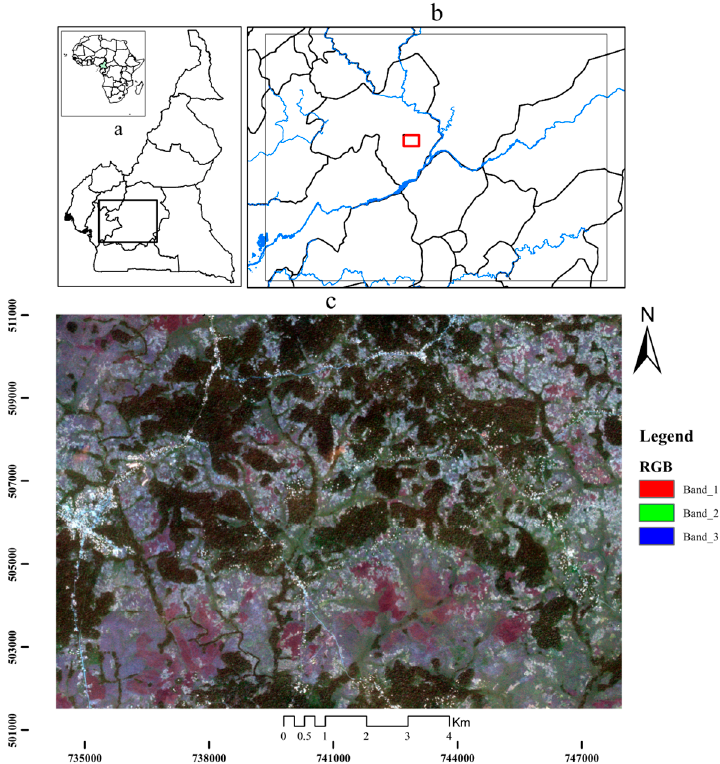
Figure 1. ( a ) The study area, which is located in the center region of Cameroon; ( b ) the study landscape, in red, within the Bam and Inoubou administrative department; and ( c ) s RapidEye natural color image (Red, Green, and Blue (RGB) spectral bands) that reveals a mosaic of forest and savannah vegetation in the landscape.